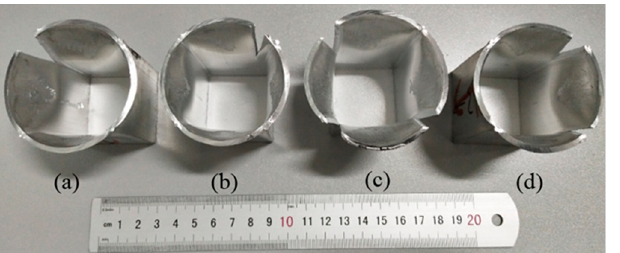
Figure 16. Fracture modes of expansion test samples at the ram speed of: ( a ) 3 mm/s; ( b ) 7 mm/s; ( c ) 9 mm/s; ( d ) 11 mm/s.